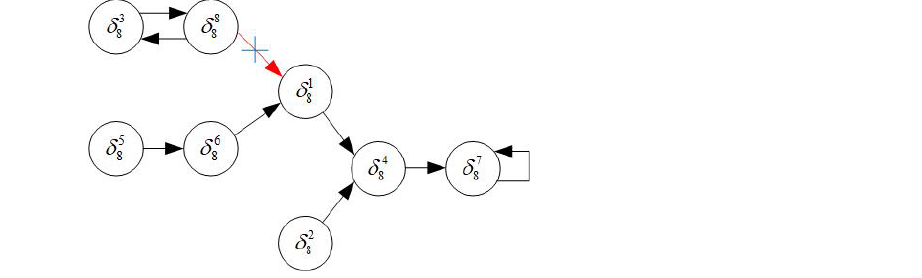
Figure 2. The state transfer graph of system (20) under P and the control (21) with s = 8, k ∗ = 2 and α (cid:48) ( 2,8 ) = 3.